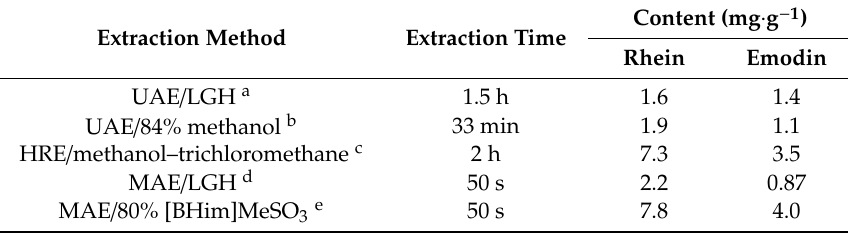
Table 1. Comparison between microwave-assisted extraction (MAE) with [BHim]MeSO 3 and other extraction methods. UAE—ultrasound-assisted